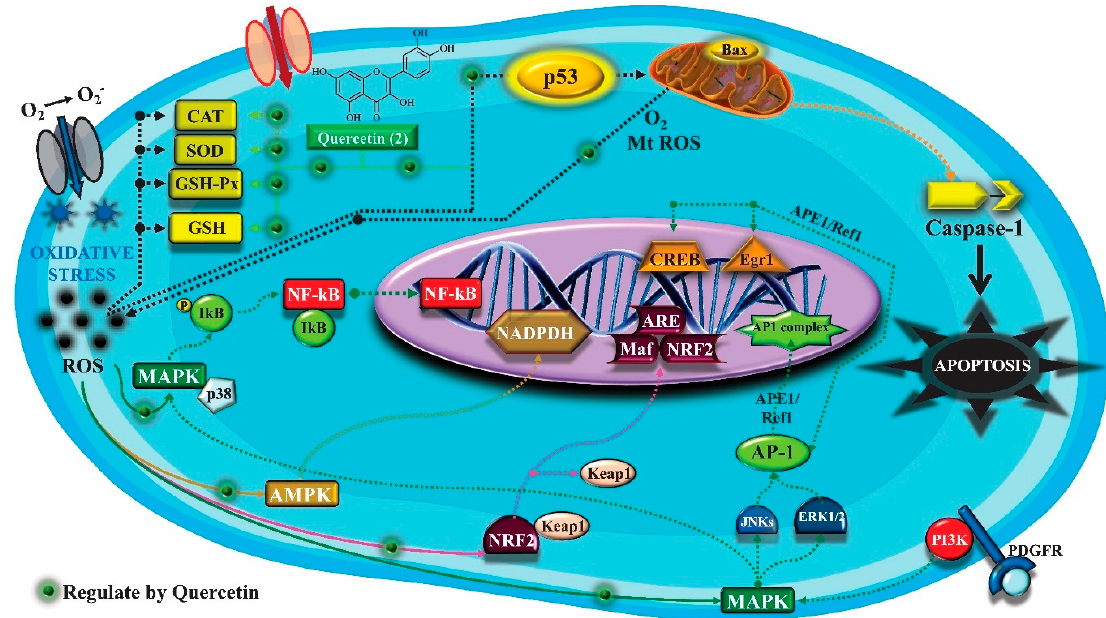
Figure 2. Antioxidant effect of quercetin on enzyme activity, signal transduction pathways and reactive oxygen species (ROS). Several conditions and environmental factors can increase ROS production. Besides, the mitochondrial electron transport chain is an important source of intracellular ROS generation. Flavonoid uptake occurs either via passive diffusion through cell membrane, or through membrane bound transport proteins [54]. After entering the cell, quercetin acts through the regulation of the enzyme-mediated antioxidant defense system and the non-enzymatic antioxidant defense system. Nuclear factor erythroid 2–related factor 2 (NRF2), AMP-activated protein kinase (AMPK), and mitogen-activated protein kinase (MAPK) pathways induced by ROS to promote the antioxidant defense system and maintain oxidative balance can also be regulated by phenolic compounds such as quercetin [59]. Through the neutralizing effect of ROS, quercetin can develop important anti-inflammatory effect due to inhibition of the Nuclear Factor-kappa B (NF-KB) pathway, preventing the activation of NRLP3 inflammasome (shown in Figure 1B). Through the p53 pathway, ROS induce apoptotic events. Therefore, quercetin can prevent apoptosis induced by excess ROS. In addition, it enhances the production of Apurinic/apyrimidinic Endonuclease 1/ Redox Effector Factor